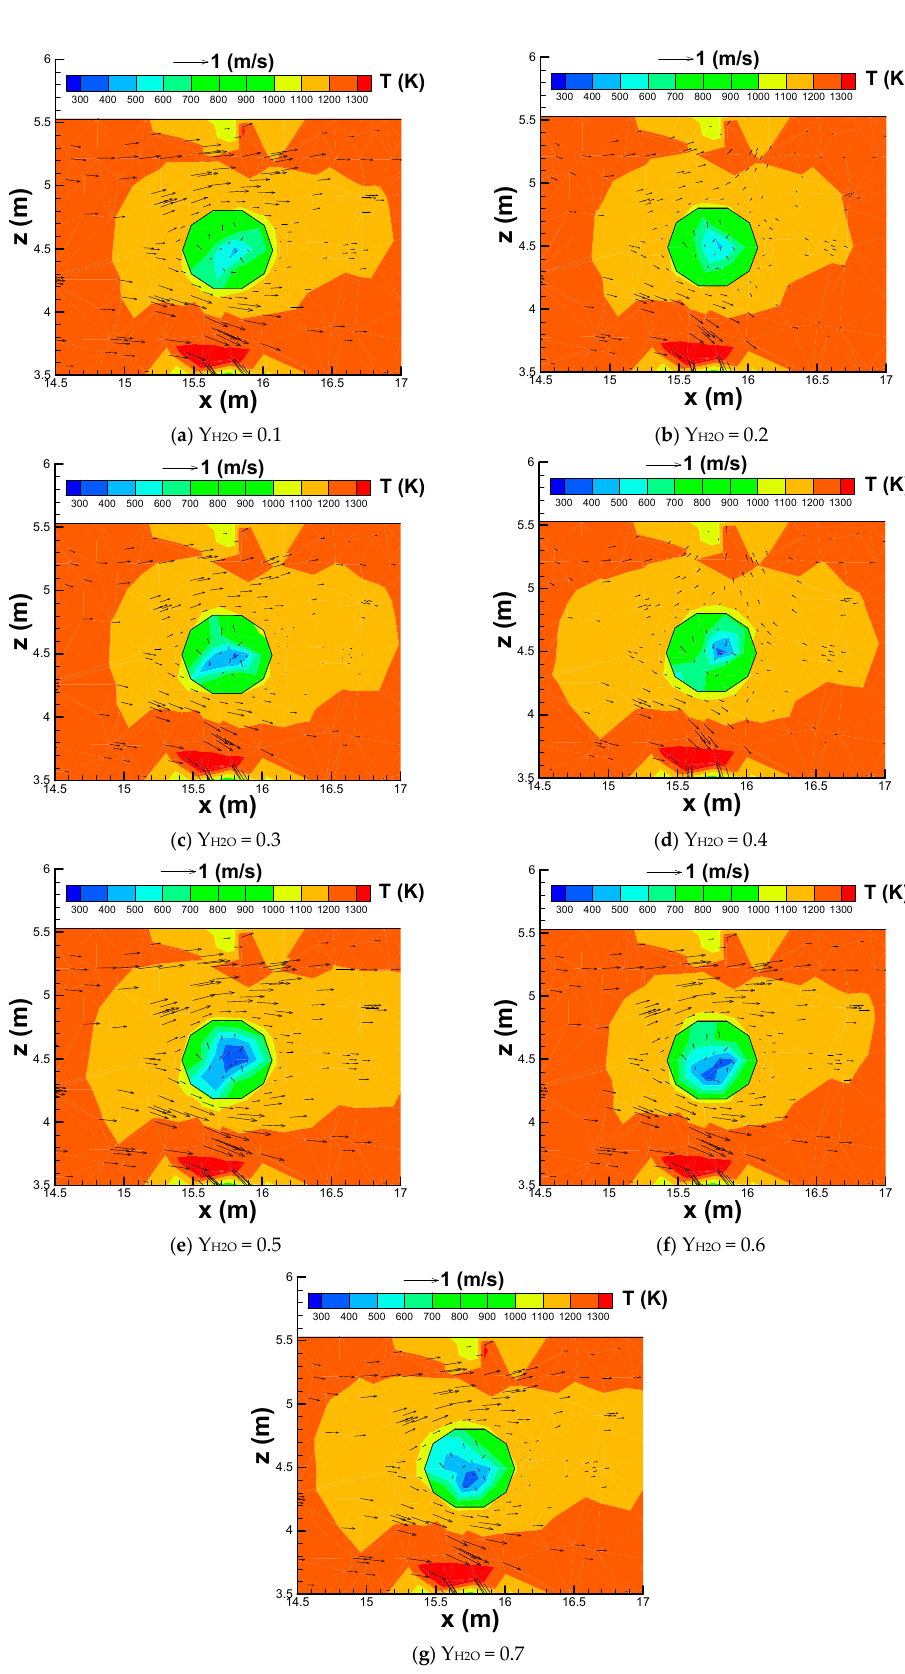
Figure 7. Comparison of the temperature and velocity vector distributions at y = 6 m around a reforming tube using different mole fractions of steam.